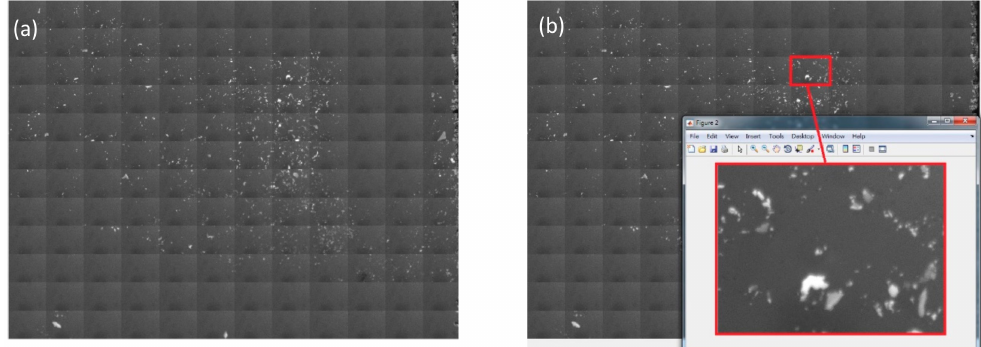
Figure 2. Illustration of the rapid sample finding microscope. ( a ) A wide field microscopic image combined with 12 × 12 small high resolution images. The total area is about 3 × 4 mm 2 . ( b ) When one clicks on a small area in the large image, a new window pops up with a magnified view of that area. The size of each small area is about 300 × 250 µ m 2 . The magnification is 1600 ×